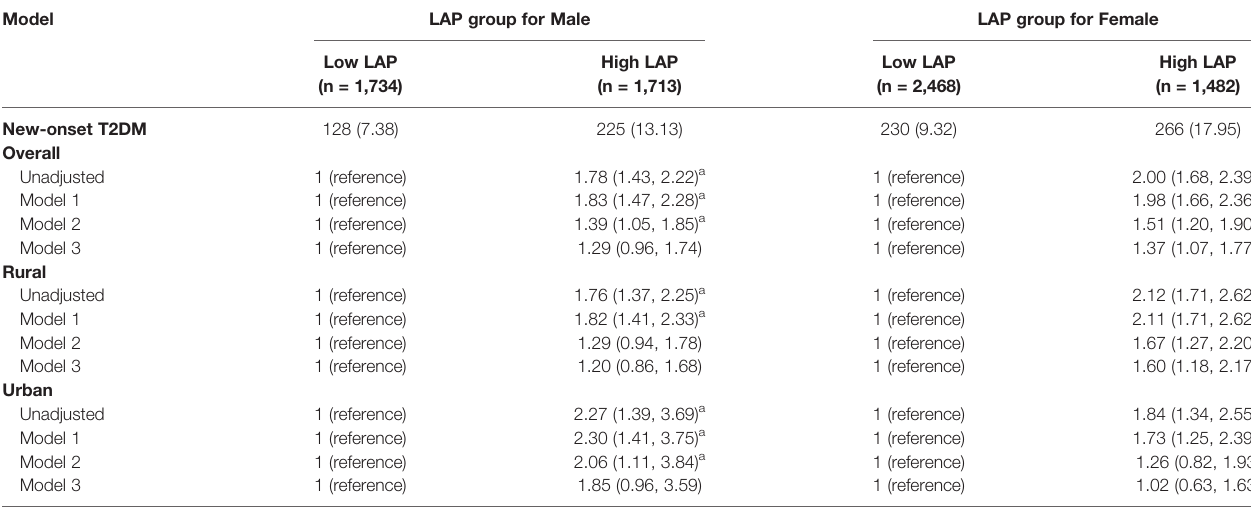
TABLE 2 | Hazard ratios for T2DM by LAP phenotypes in middle-aged and older Chinese, CHARLS 2011-2018. Model LAP group for